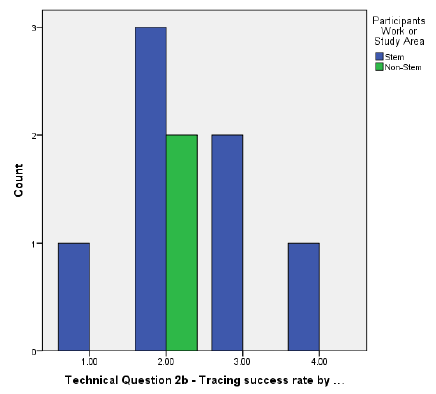
Figure 7. Success in tracing